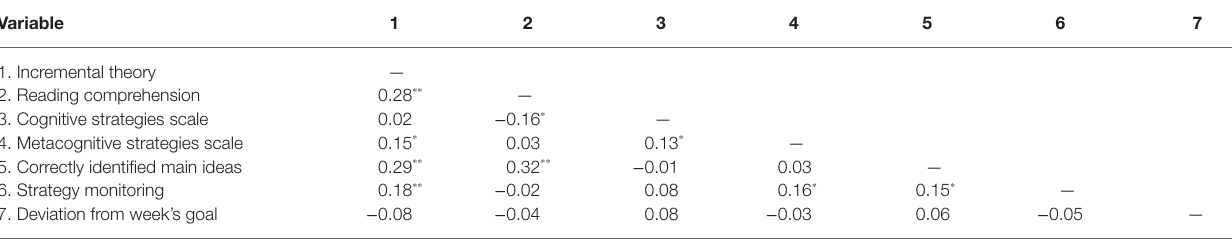
TABLE 2 | Pearson correlation matrix for all variables before the